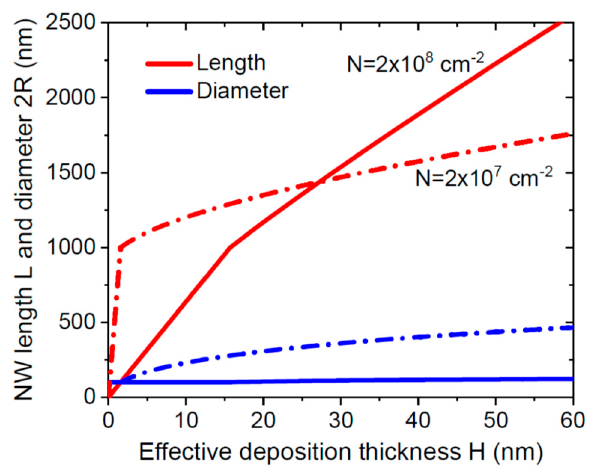
Figure 2. NW length and diameter versus H at a fixed λ of 1000 nm and R 0 = 50 nm, for two different surface densities N indicated in the legends. The curves are obtained in the case of VPE SAG ( χ = ϕ = 1 ). The rapid axial NW growth at a constant radius is converged to the slower one at L = λ . Lower-density NWs grow faster in the first step but slower towards the end. The effective deposition thickness is related to the growth time as H = vt , so that the curves can equivalently be presented as functions of t . The same applies to the curves shown in Figure 3.